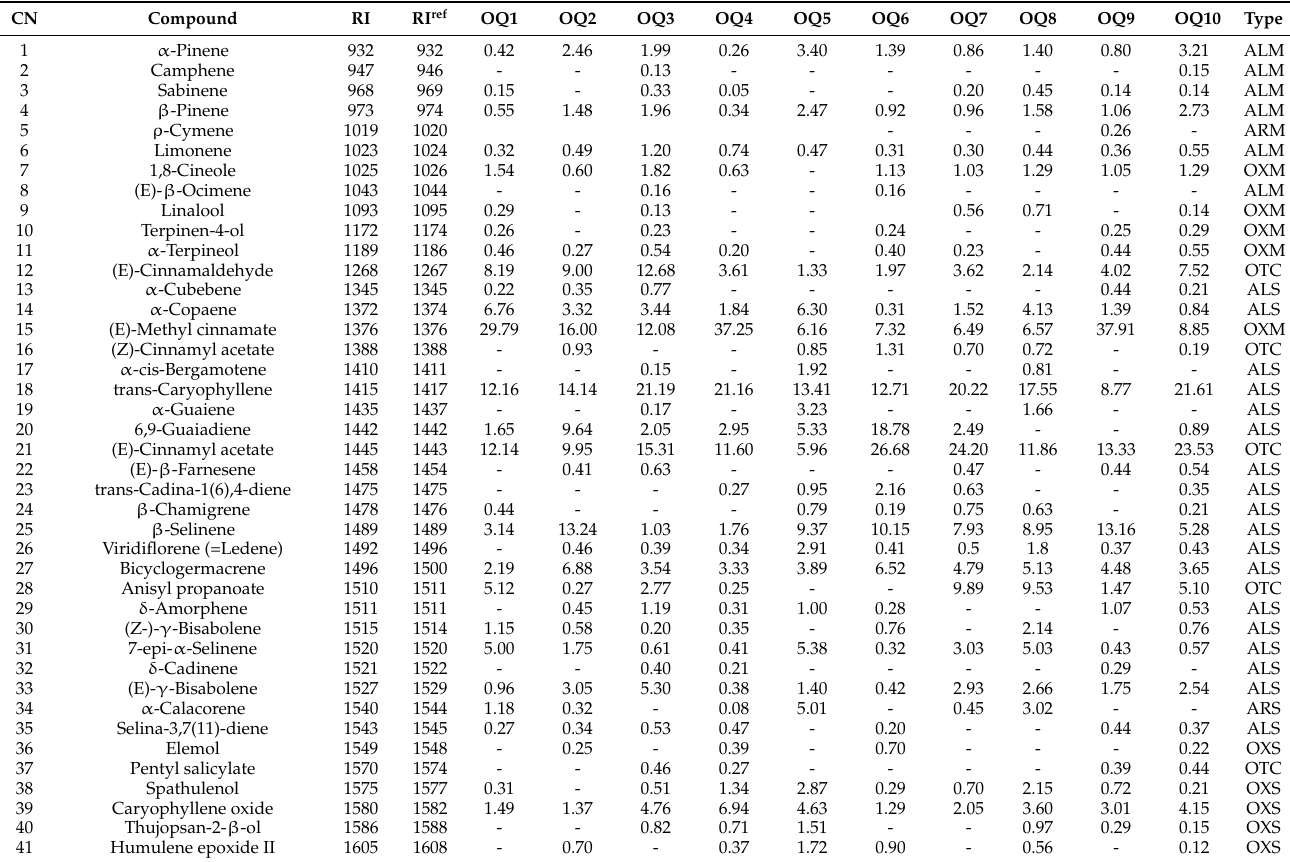
Table 2. Chemical composition of the essential oil from ishpingo ( Ocotea quixos ) leaf